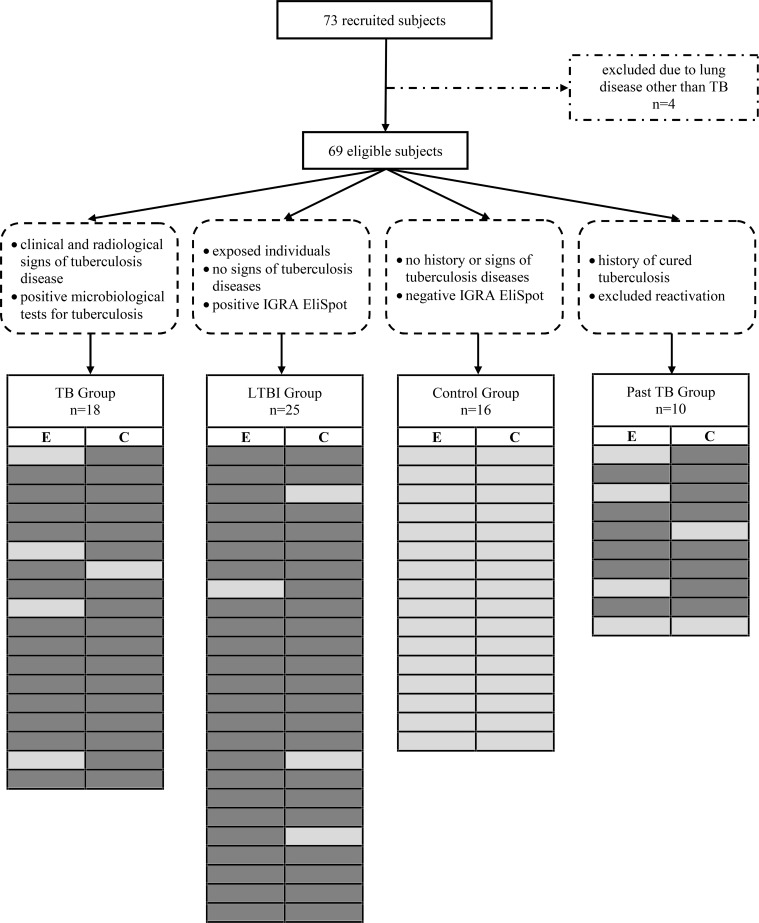
Flow chart of patients included in this study.TB = tuberculosis; LTBI = latent infection with M. tuberculosis; control = healthy individual with negative EliSpot-IGRA result; E = ESAT-6; C = CFP-10; dark grey = positive test result in the EliSpot-IGRA; light grey = negative test result in the EliSpot-IGRA.